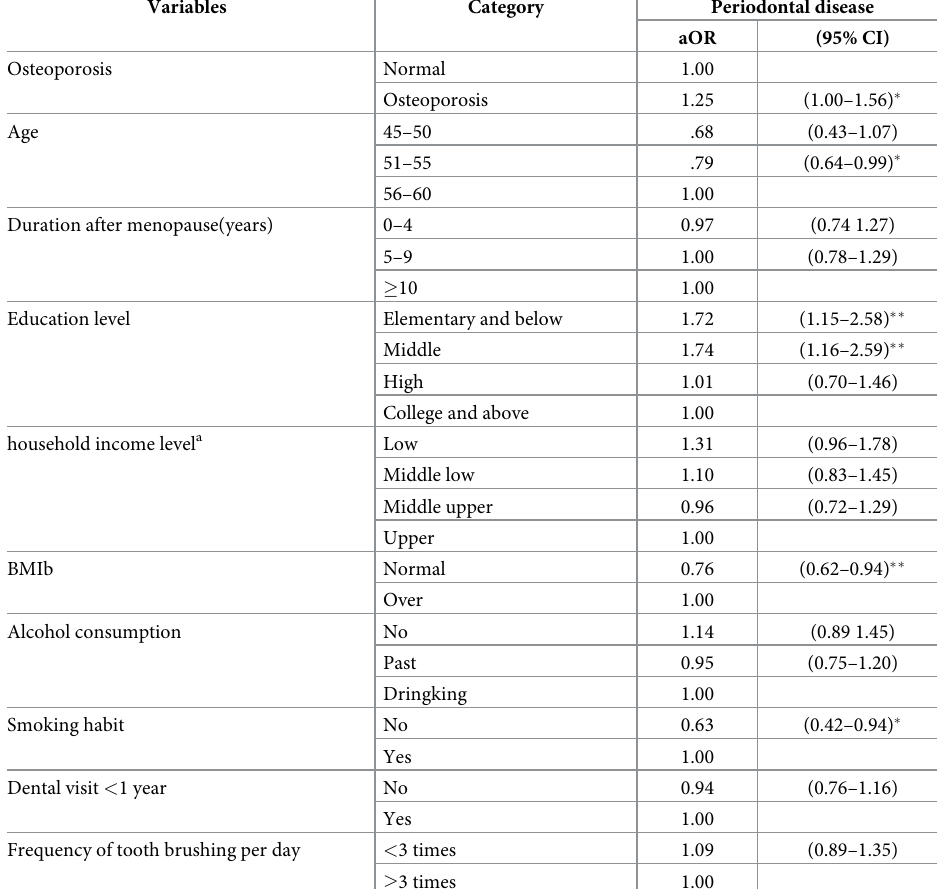
Table 2. Association between osteoporosis and periodontal disease according to general characteristics, lifestyle factors, and oral care behavior (n = 2,573).